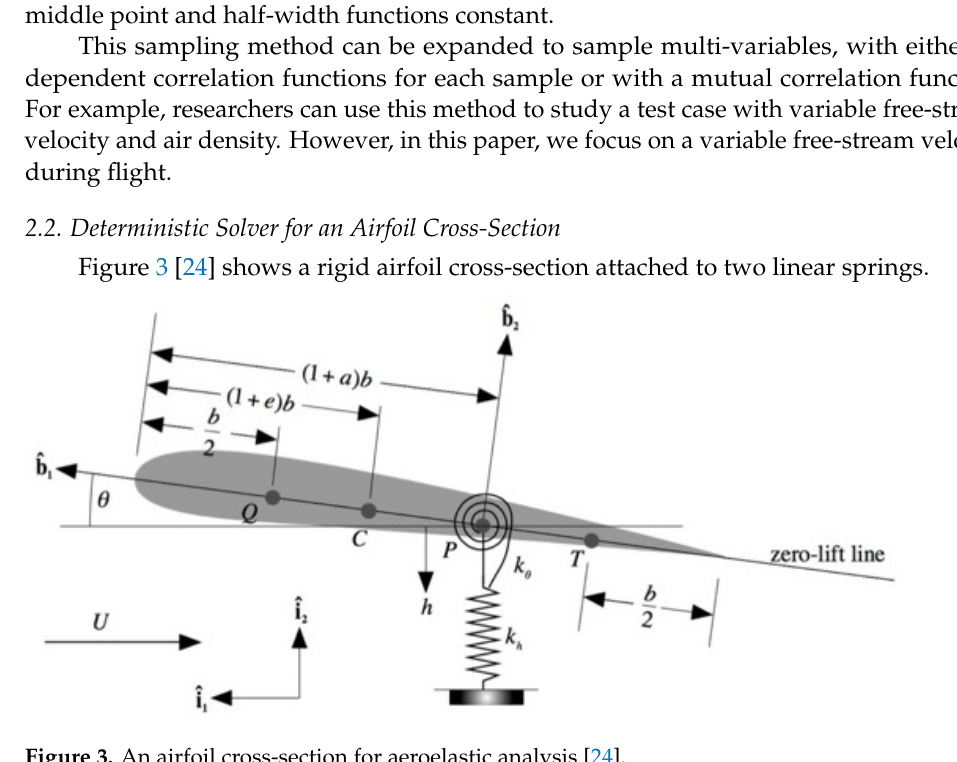
Figure 3. An airfoil cross-section for aeroelastic analysis